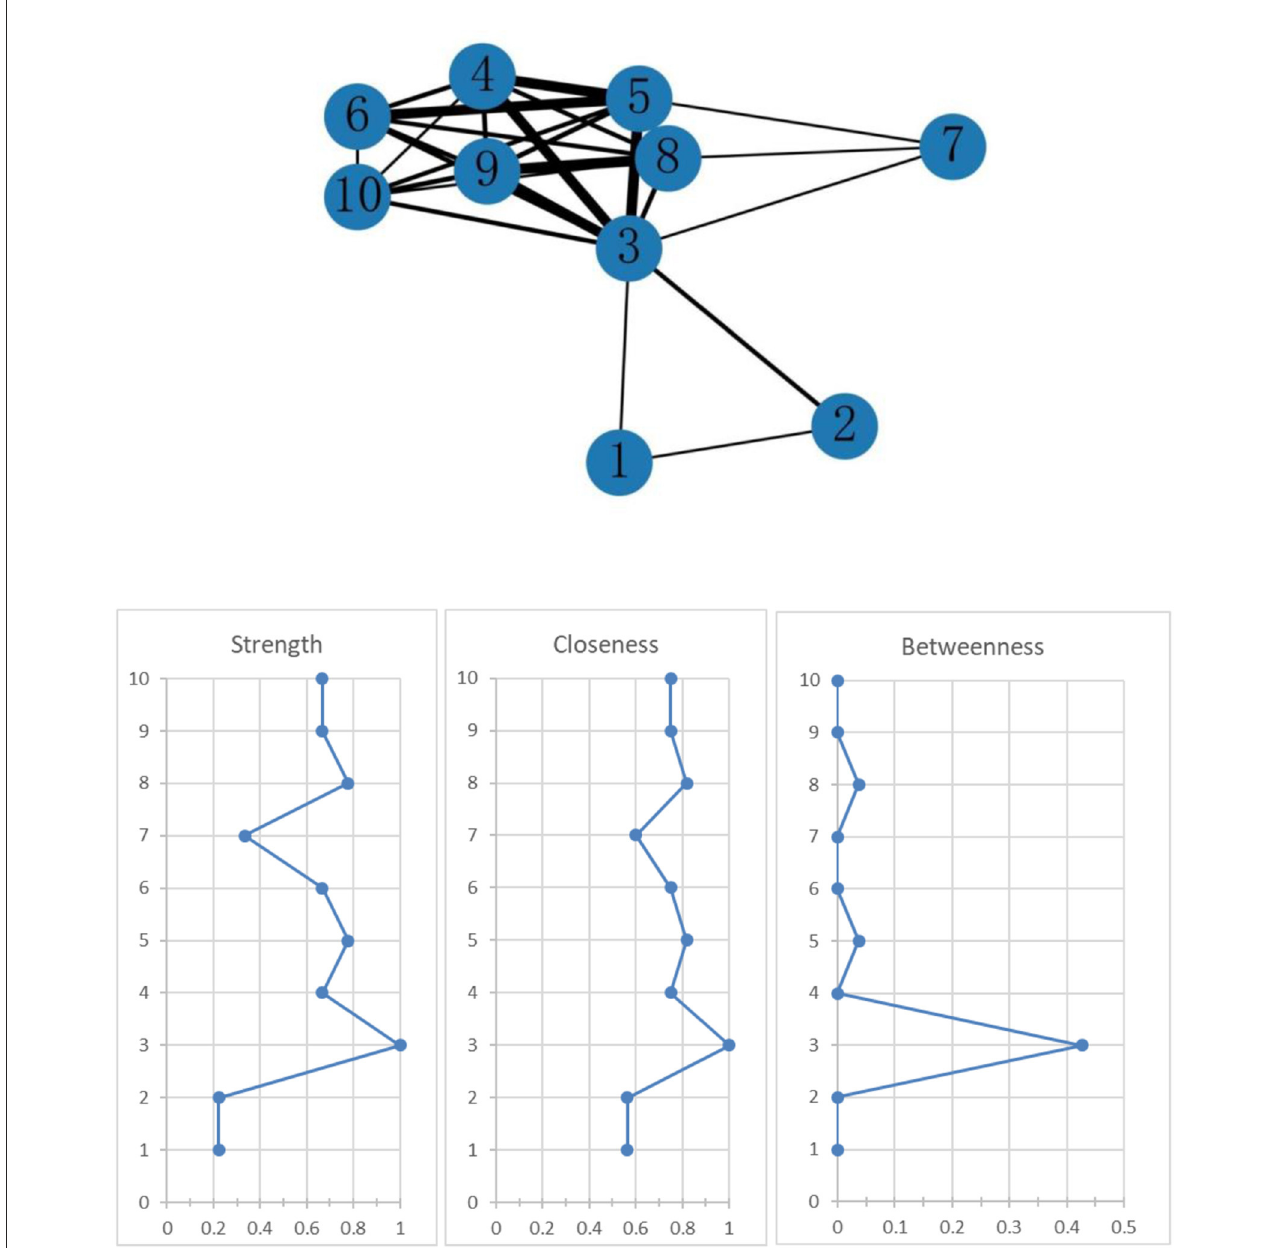
FIGURE2 Network of mental health symptom clusters and centrality indices. 1. Somatization symptom cluster; 2. Negative affect symptom cluster; 3. Cognitive function symptom cluster; 4. Interpersonal communication symptom cluster; 5. Cognitive process symptom cluster; 6. Social adaptation symptom cluster; 7. Sleep disturbance; 8. Loneliness; 9. Sadness; 10.